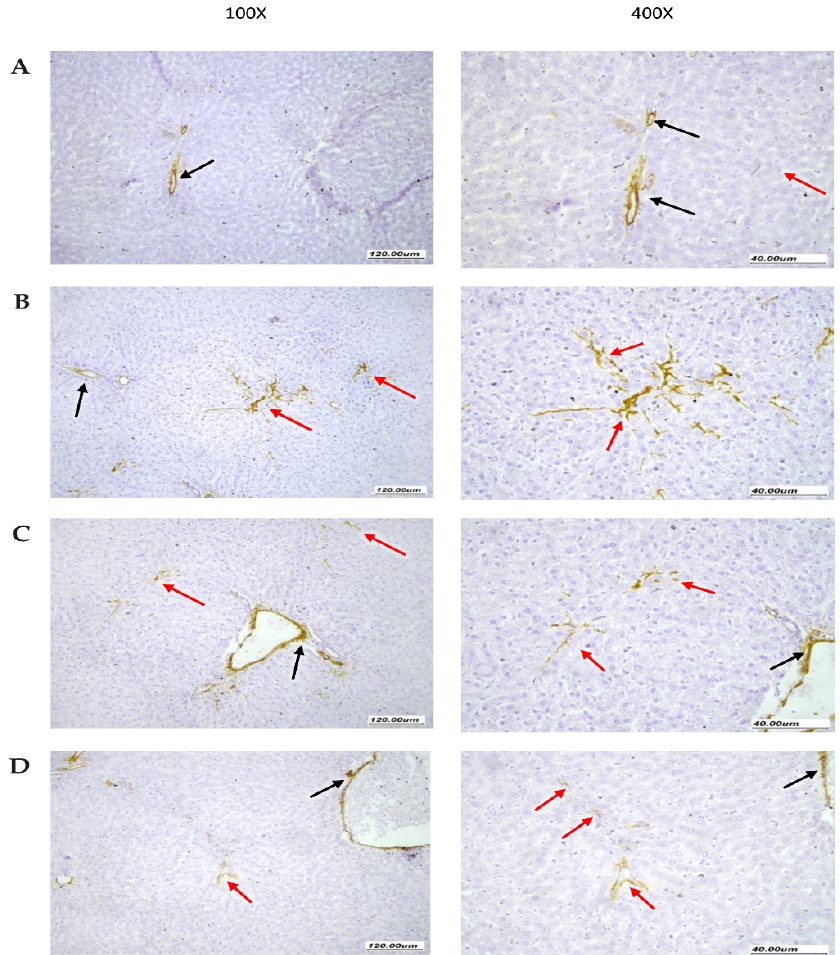
Figure 7. Immunohistochemistry for alpha-smooth muscle actin in rat livers. ( A ) Normal liver tissue showing SMA staining limited to vascular walls (black arrow). The surrounding liver parenchyma shows no SMA staining (red arrow). ( B ) Liver tissues from NASH control group showing moderate SMA staining of stellate myofibroblast cells (red arrow) extending between liver cells within liver parenchyma with arborizing branching pattern between hepatocytes along sinusoidal walls. There are scattered vessels showing staining at periphery (black arrow). ( C ) Liver tissues from the NASH + hemp seed oil group showing focal moderate SMA staining of stellate myofibroblast cells (red arrow) extending early between liver cells within liver parenchyma. There are scattered vessels showing staining at the periphery (black arrow). ( D ) Liver tissues from the NASH + NEF#4 hemp seed oil group showing minimal very focal weak SMA staining of a very small number of myofibroblast cells (red arrow), minimally extending between liver cells within the liver parenchyma. There are scattered vessels showing staining at the periphery (black arrow).